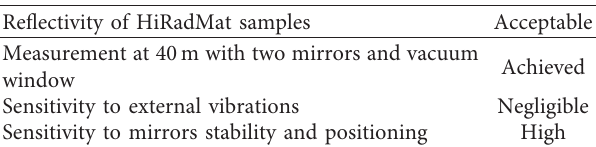
Figure 15: Generated and LDV-acquired signals are superposed (5 ÷ 1000Hz). Table 7: Qualification tests on the